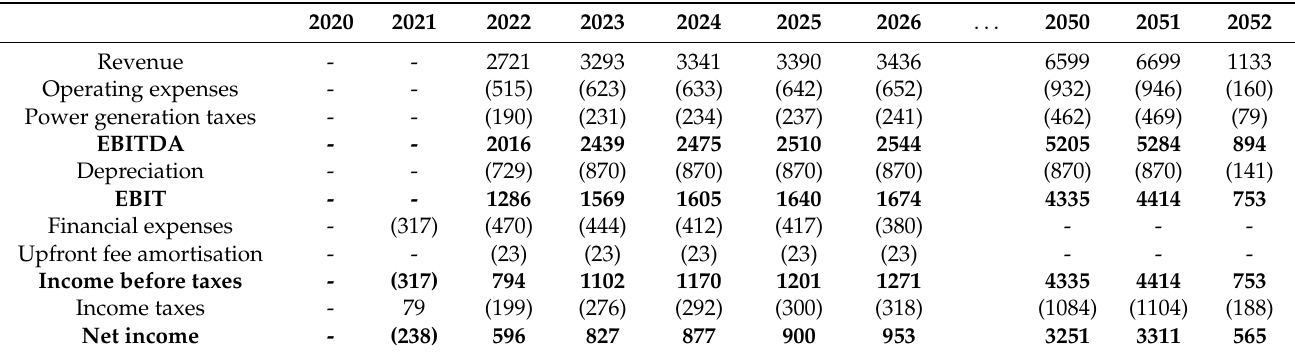
Table 4. Pro forma profit and loss statement for the base case.